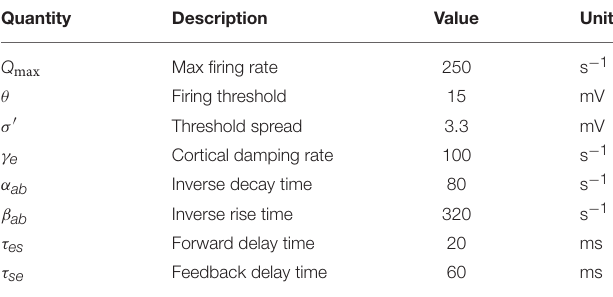
TABLE 1 | Physiologically estimated model parameters for normal adults in the alert, eyes-open state (Robinson et al., 2004).